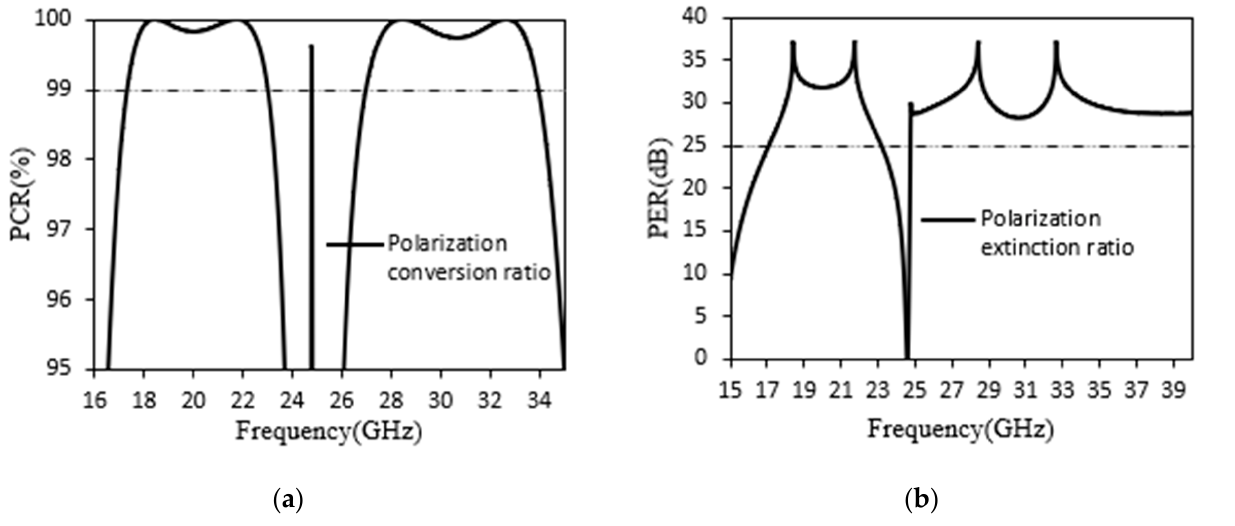
Figure 4. The calculated results of proposed converter under y -polarized incidence. ( a ) Linear-to- circular polarization conversion ratio (%) and ( b ) polarization extinction ratio (dB).